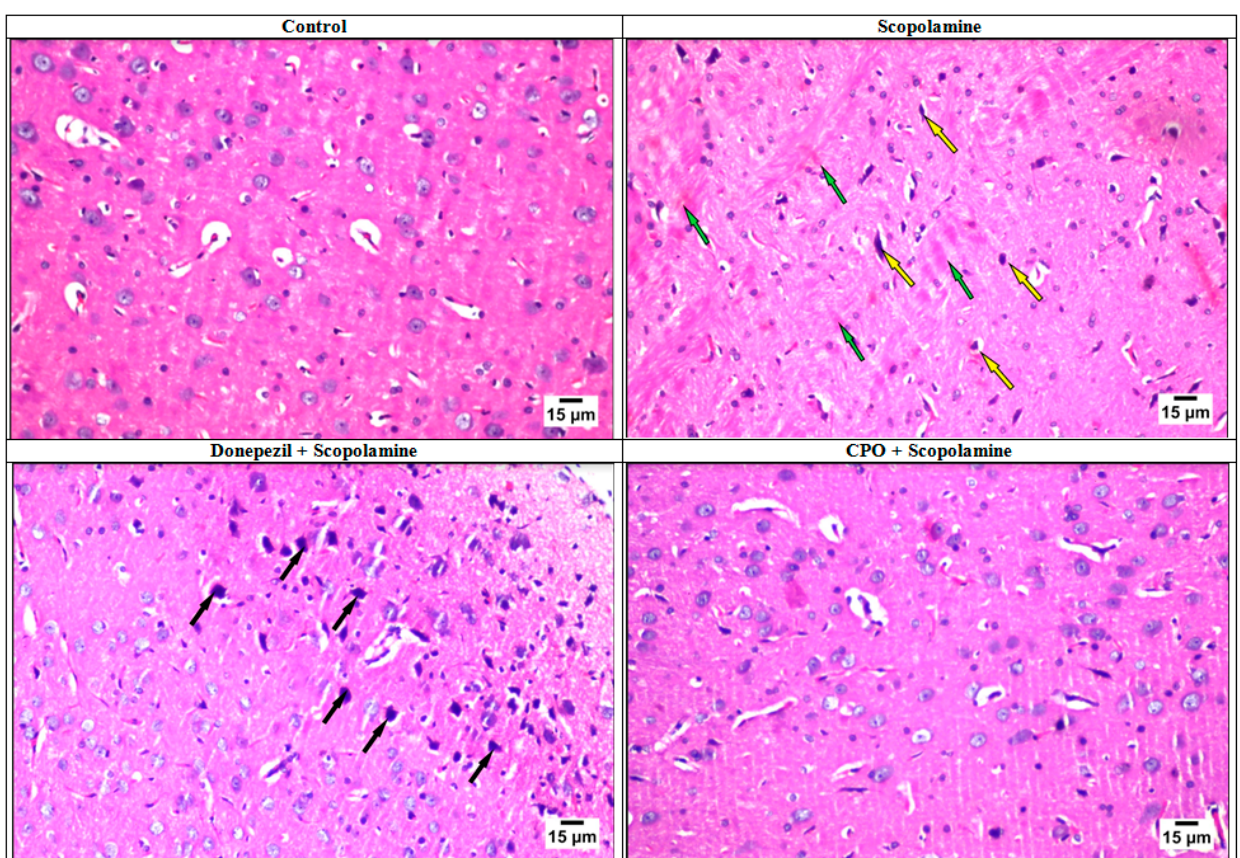
Figure 4. Microphotographs (stained by hematoxylin and eosin) showing striatum in the brain of rats from the control, scopolamine-, donepezil-, and pepper oil-treated groups. Pyknotic and degenerating neurons (black arrows), eosinophilic plaques (green arrows), and neuronal degeneration (yellow arrows). This figure was adopted from Mostafa [10].